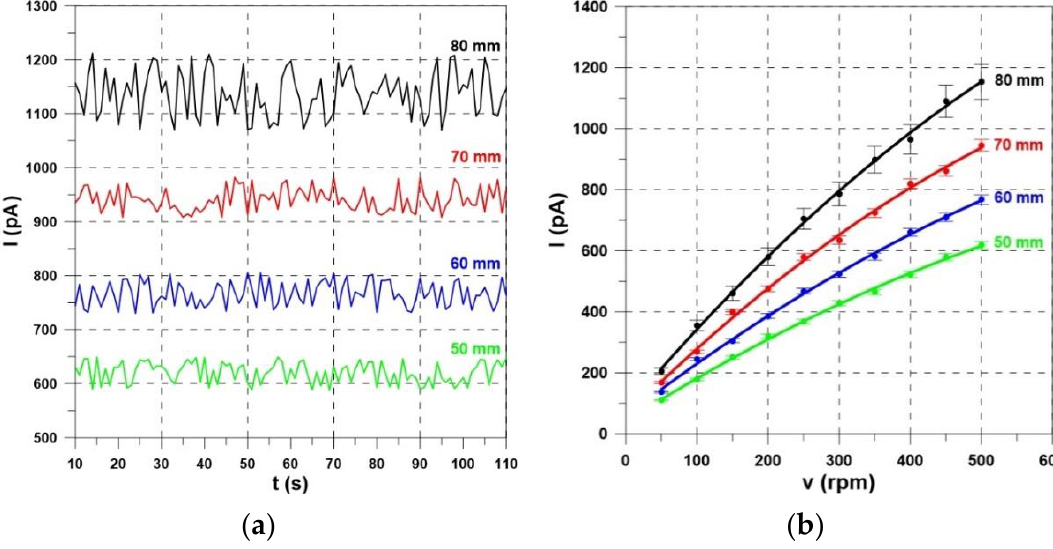
Figure 4. Electrification current of Nycodiel 1255 synthetic ester vs. ( a ) rotating time ( v = 500 rpm) and ( b ) rotational velocity for discs of di ff erent diameters ( d = 50, 60, 70, 80